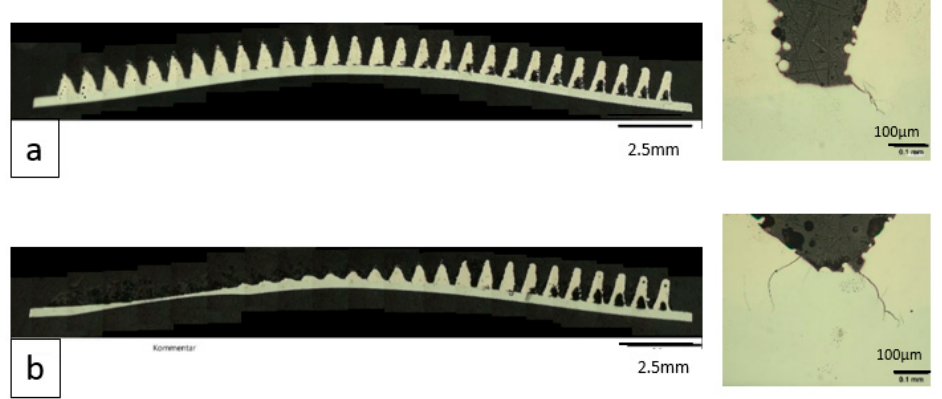
Figure 10. Microscope images of the hybridized NiTi SMA strips ( a ) before and ( b ) after static testing.